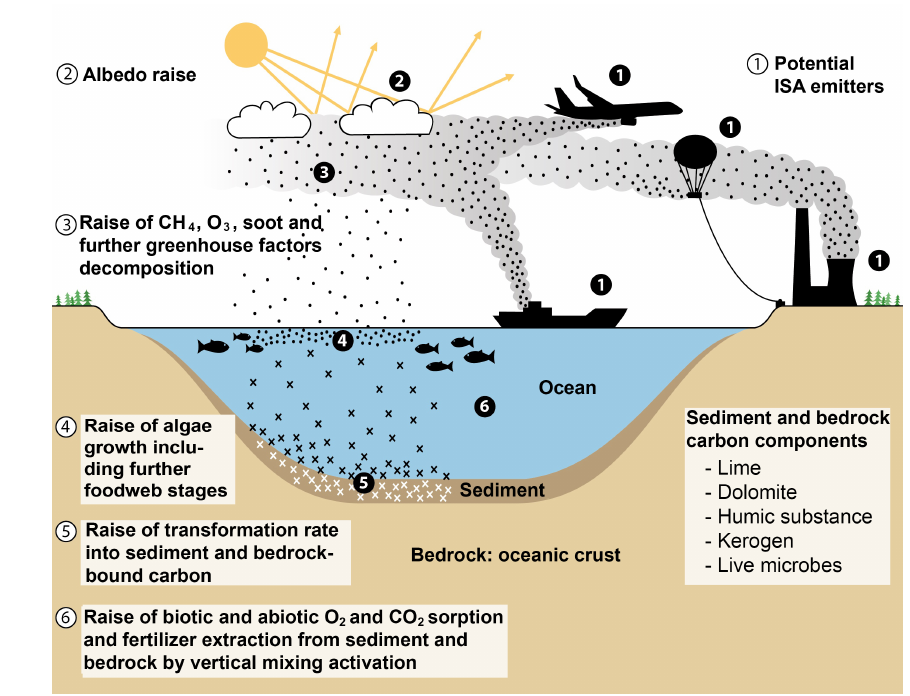
Figure 7. Summary of the principal cooling effects of the proposed iron salt aerosol